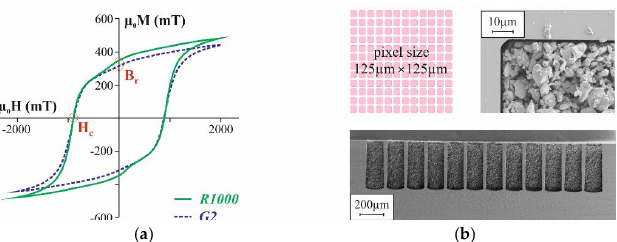
Figure 6. ( a ) Typical magnetization curves for NdFeB micromagnets of design R1000 and G2 as fabricated within this work. ( b ) Layout of design G2 and SEM micrographs of one pixel from the top as well as a diced through chip. The NdFeB particles are agglomerated by ALD so that the parts of the porous structures remaining after dicing do not fall out of the cut through micro molds. On chips of design M5 surface profile, scans of the embedded micromagnets were obtained using a Dektak 3ST profilometer. The scans reflect the impact of the filling pro- cedure on the filling level as function of the mold width. More details regarding substrate processing or properties of the NdFeB-based micromagnets can be found in [4,5]. For all tests, NdFeB powder MQFP-B+(D50 = 5 µm)-10215-089 from Magnequench has been utilized. For B r and H ci as typical values 865–895 mT and 701–836 kA/m are spec- ified in the data sheet.